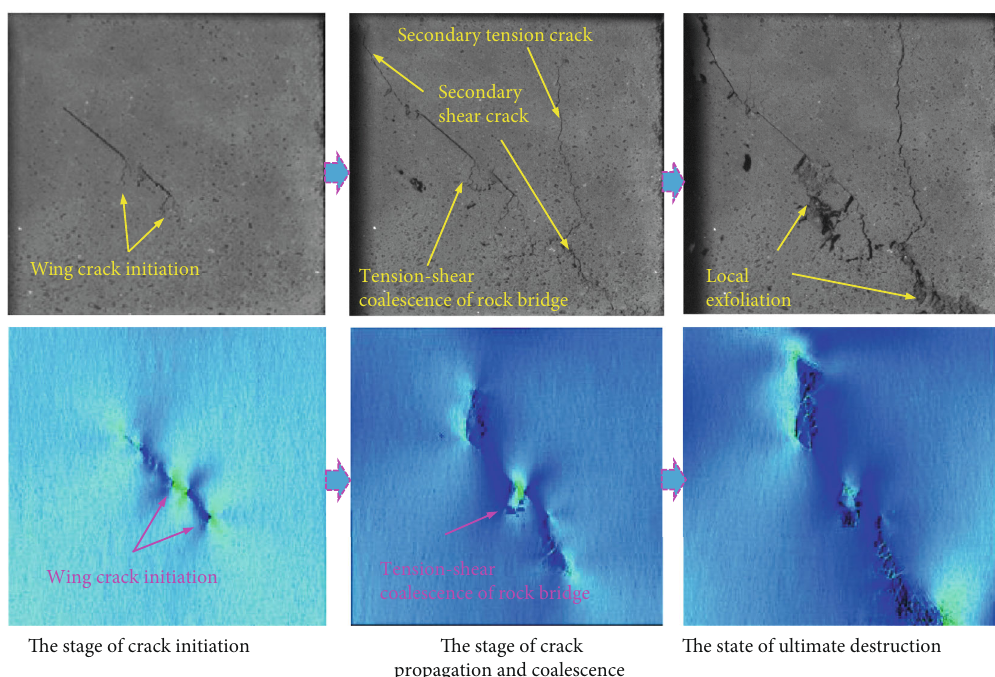
Figure 21: Comparison of numerical simulation and test